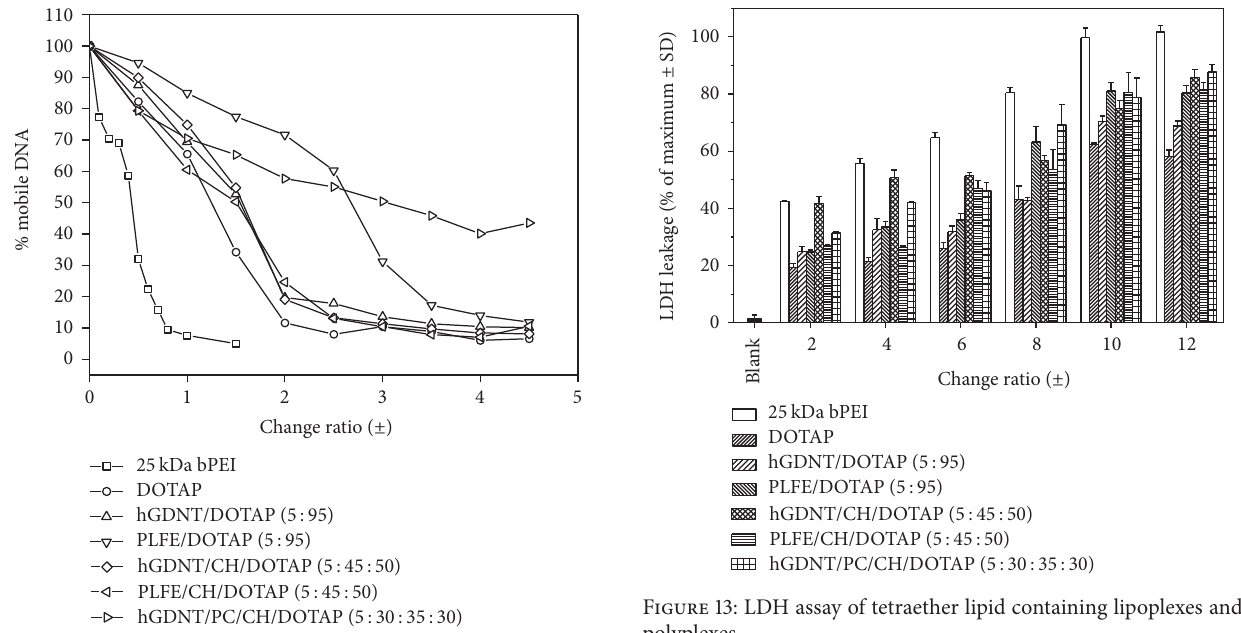
Figure 11: pDNA immobilisation of lipoplexes at increasing N/P (+/ − ) ratios. DNA complexes with increasing amounts of tetraether lipids (PLFE or hGDNT) were prepared and analysed with gel-red (1x).